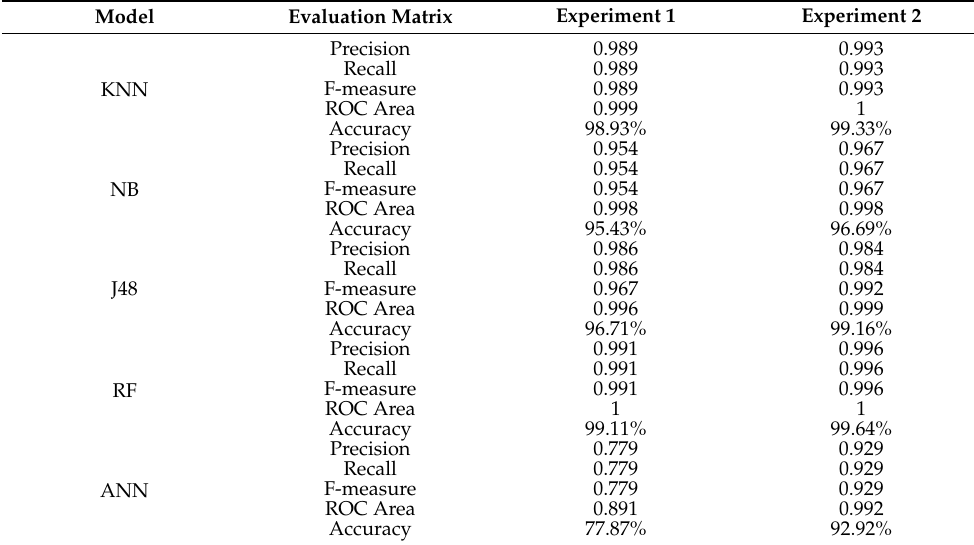
Table 7. Experiment